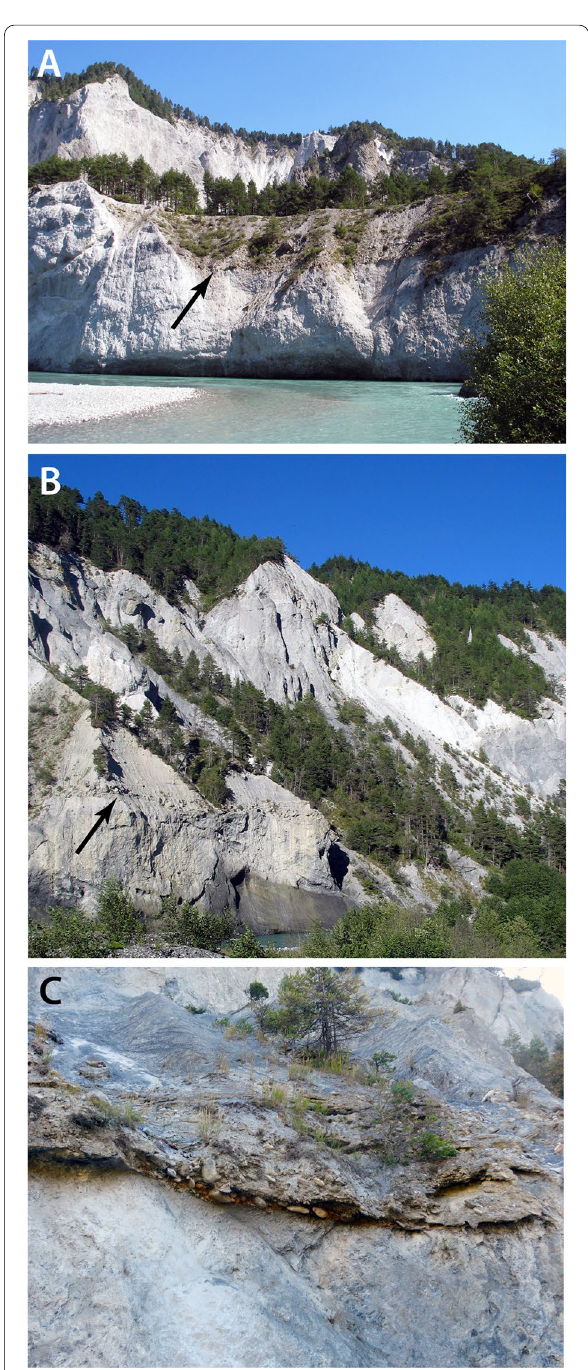
Fig. 18 Incision of the Ruinaulta gorge. A Ancestral valley floor (black arrow) at Chrummwag located 40 m above the modern Vorderrhein. B Ancestral riverbed (black arrow) perched on the cliffs of Ruinas dallas Foppas. C Ancestral riverbed perched on the cliffs of Islahalda. Pebbles include rounded cobbles of crystalline basement. Photos A.